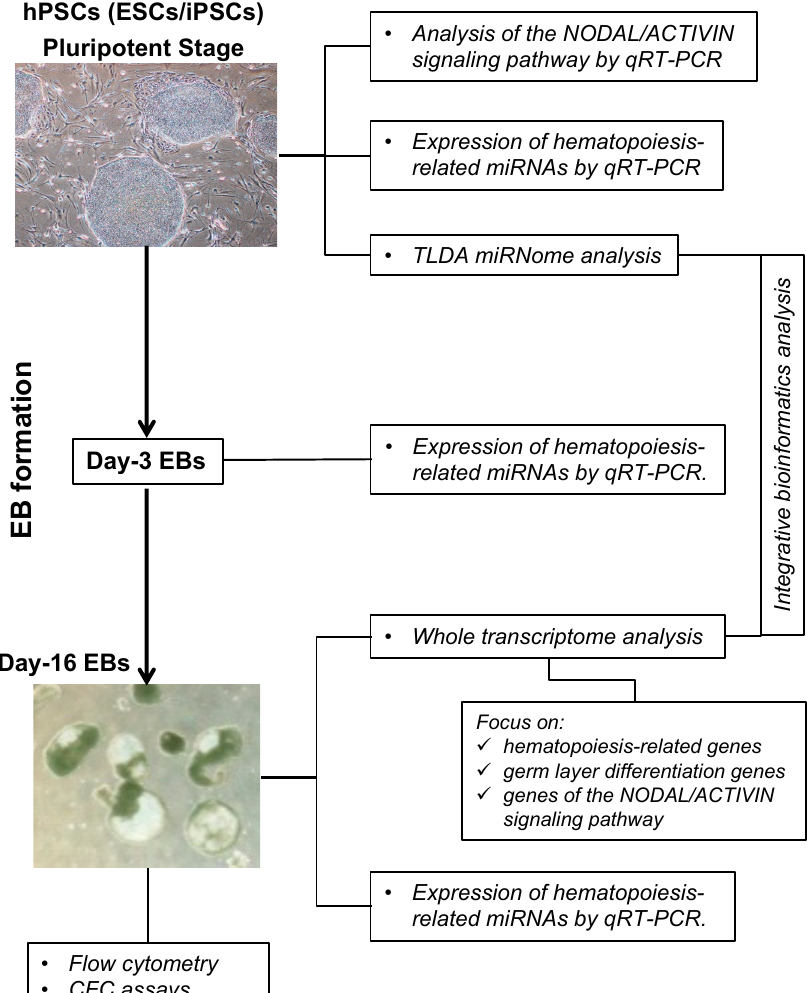
Figure 1. Comprehensive analysis of the hematopoietic potential of human pluripotent stem cells. Human pluripotent stem cells (hPSCs) were differentiated into embryoid bodies (EBs) using appropriate hematopoietic factors. Flow cytometry, colony-forming cell assays and gene expression analysis were performed on day-16 EBs. For miRNA expression kinetic analysis, hPSCs or EBs were collected at day 0, 3, and 16 of culture. The global miRNome analysis was carried out on hPSCs at pluripotent stage. ESCs, embryonic stem cells; iPSCs, induced pluripotent stem cells; TLDA, TaqMan Low Density Array; CFC, colony-forming cell.